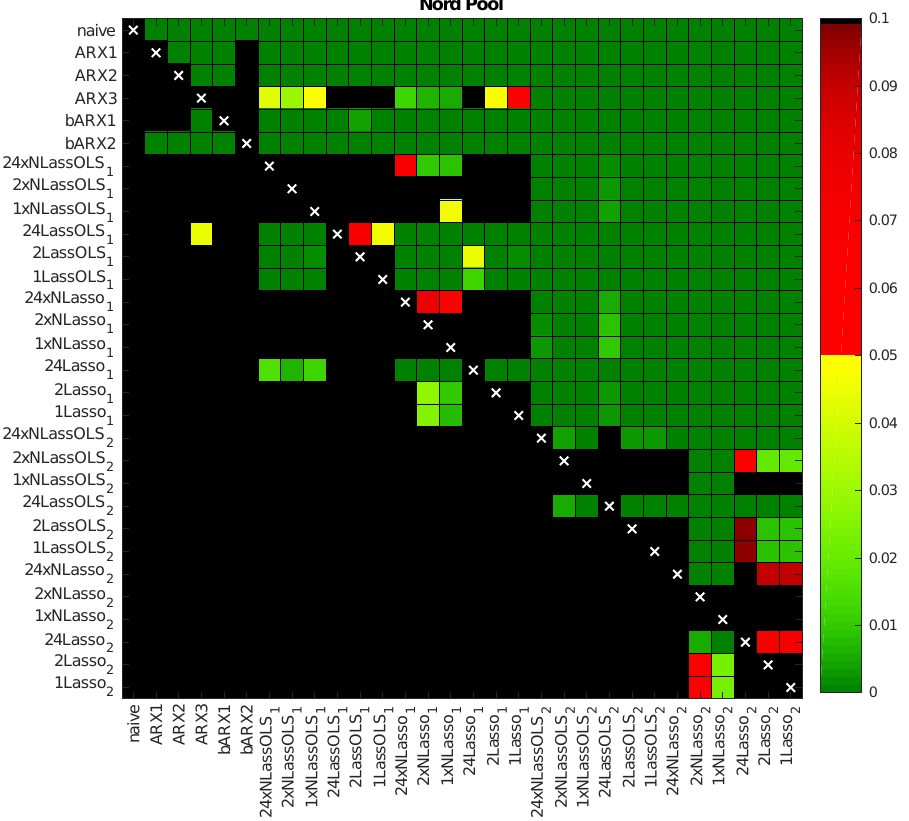
Figure 4. Results of the ‘multivariate’ variance stabilizing transformations (VSTs) multi-parameter Diebold–Mariano (DM) test for Nord Pool for the same 30 models as in Table 1 and the N-PIT transformation. A heat map is used to indicate the range of the p -values—the closer they are to zero ( → dark green), the more significant the difference is between the forecasts of a model on the X-axis (better) and the forecasts of a model on the Y-axis